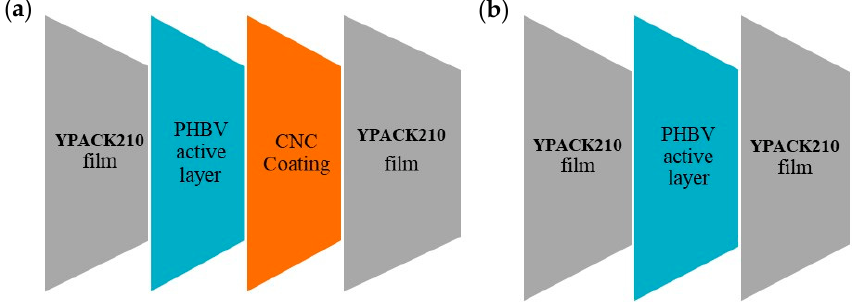
Figure 1. Scheme of the active multilayer films: ( a ) with cellulose nanocrystal (CNC) coating and ( b ) without CNC coating.